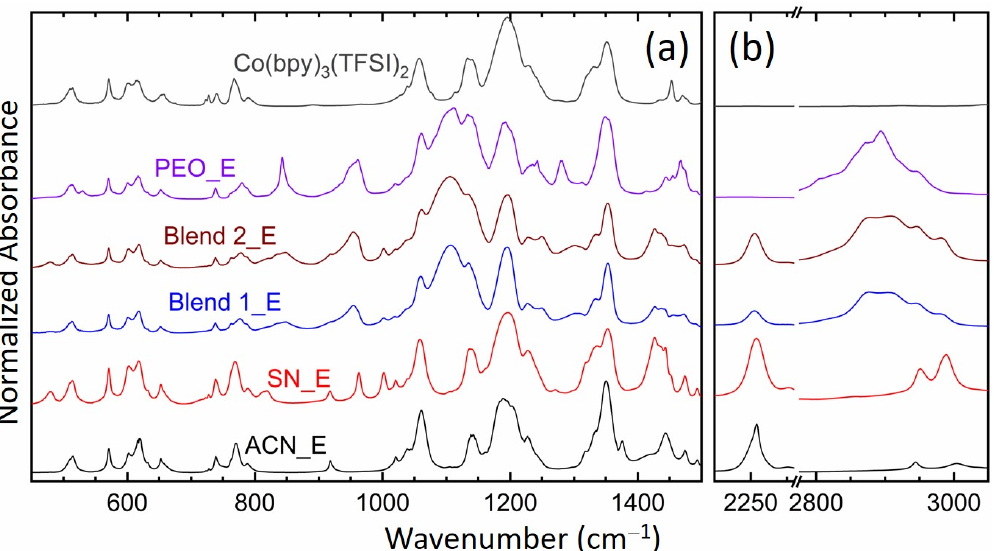
Figure 5. FT-IR spectra of the solid (SN_E, PEO_E, Blend 1_E, and Blend 2_E) and liquid (ACN_E) redox mediators. The spectrum of the Co(II) salt is also included for direct comparison. ( a ) Fingerprint region. ( b ) ν C ≡ N and ν CH regions. Table 2. Observed vibrational frequencies (in cm − 1 ) of the redox mediators, ACN_E, SN_E, PEO_E, and Blends 1_E & 2_E along with those of solvent/matrices and ionic salts.